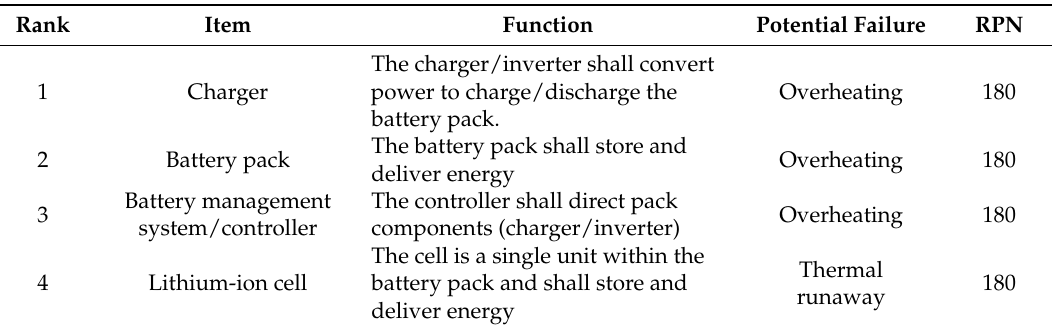
Table 5. Highest risks of